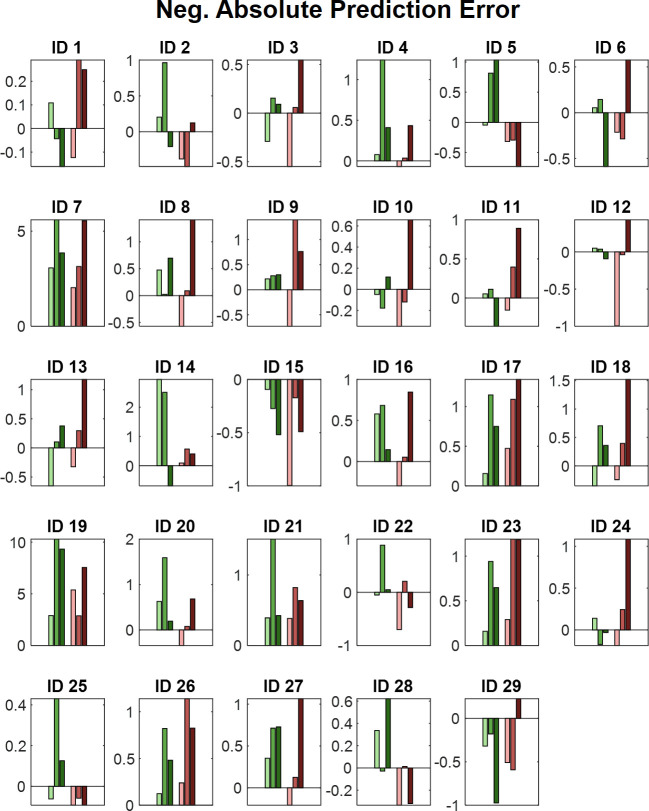
Power values for all medium and high intensity conditions with a valid modality cue.(Expect heat receive heat) averaged over all significant time–frequency–electrode samples period for each subject (ID) of the negative absolute prediction error cluster of the analysis of the reduced model. Green colors represent medium heat conditions and red colors represent high heat conditions. Color intensities depict expectation level.